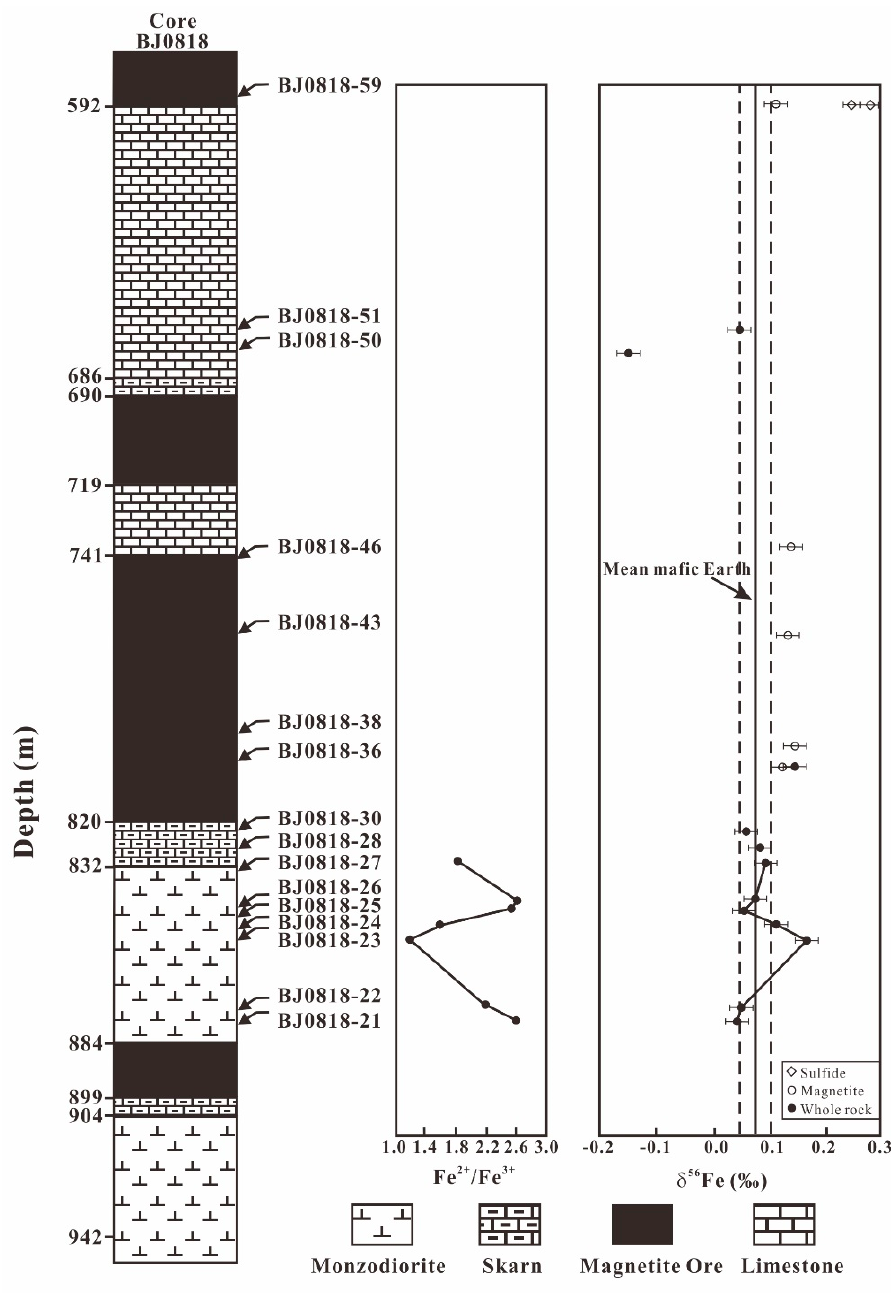
Figure 6. A synopsis of the magmatic–stratigraphic column of drill core samples BJ0818 with zonal divisions, stratigraphic variations of Fe 2 + / Fe 3 + ratios of diorites and δ 56 Fe values of whole rocks, magnetite and sulfides. The solid line represents the δ 56 Fe value of the mean mafic earth. The dashed line represents the δ 56 Fe value of less altered diorite. Diorites show a clear inverse trend between their Fe 2 + / Fe 3 + ratios and δ 56 Fe values. Except for the late-stage pyrite, all the rocks and minerals have lower δ 56 Fe values than the less altered diorite. Error bars indicate 95% CI of the mean. If we assume that iron was leached from diorites following Rayleigh fractionation, the equation (1000 + δ 56 Fe A )/(1000 + δ 56 Fe i ) = F( α B − A − 1) can be applied, where A refers to the altered diorite as the residual phase, B refers to the iron leached from the diorites, i refers to the initial δ 56 Fe values and F ( F = ( ∑ Fe 2 O 3 /TiO 2 )A/( ∑ Fe 2 O 3 /TiO 2 ) i ) refers to the proportion of iron in the altered diorites to the initial